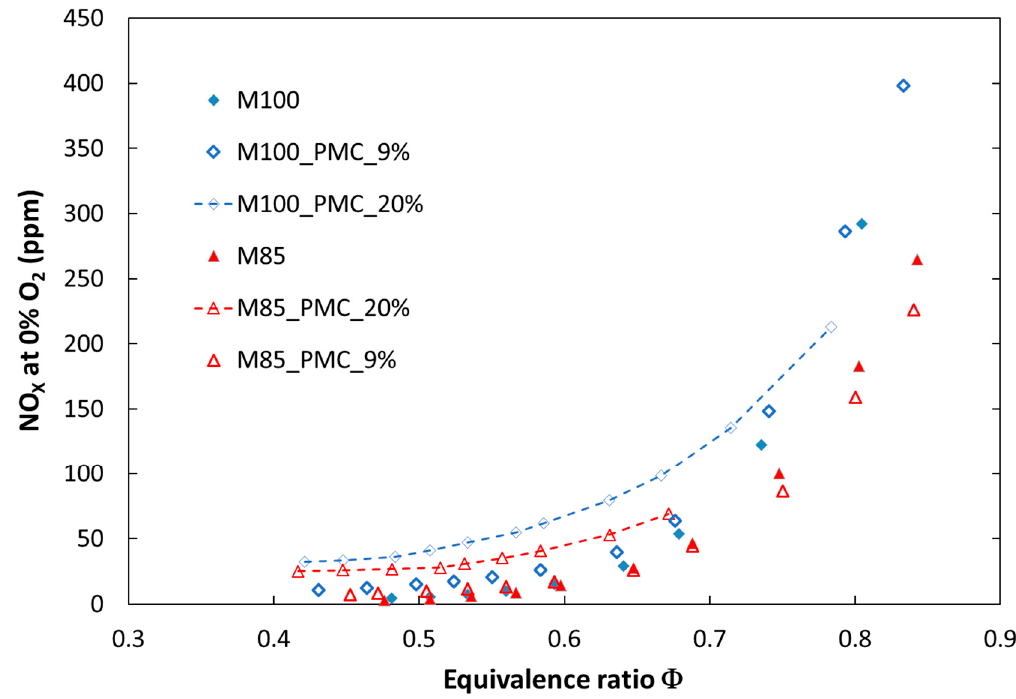
Figure 9. Comparison of experimental NO X emissions for tested fuels in various configurations of the combustion process at elevated pressure (P = 0.25